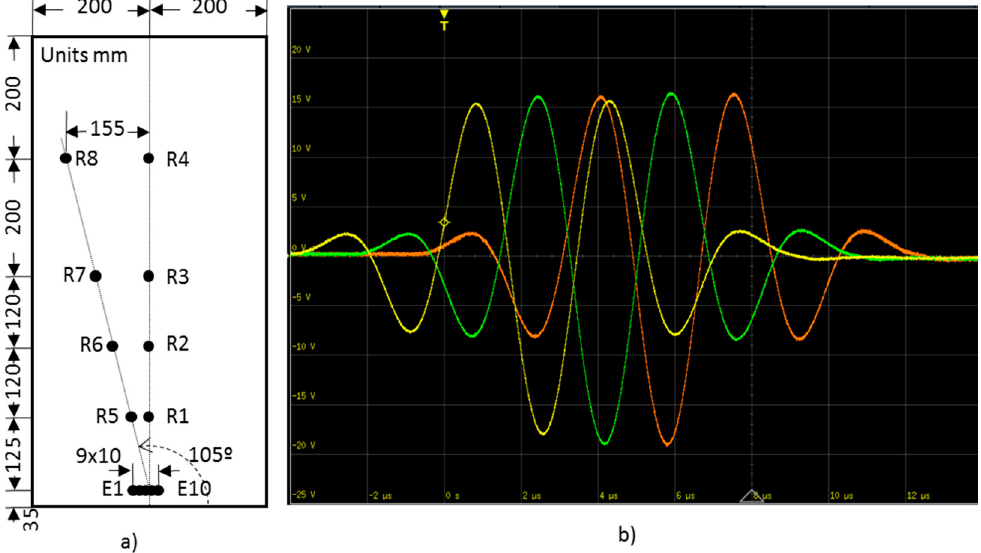
Figure 10. ( a ) Arrangement of emitters and receivers on the specimen. ( b ) Signals applied to E6 (yellow), E5 (green), and E4 (orange) according to the P2 procedure with 0.16 µs delay.